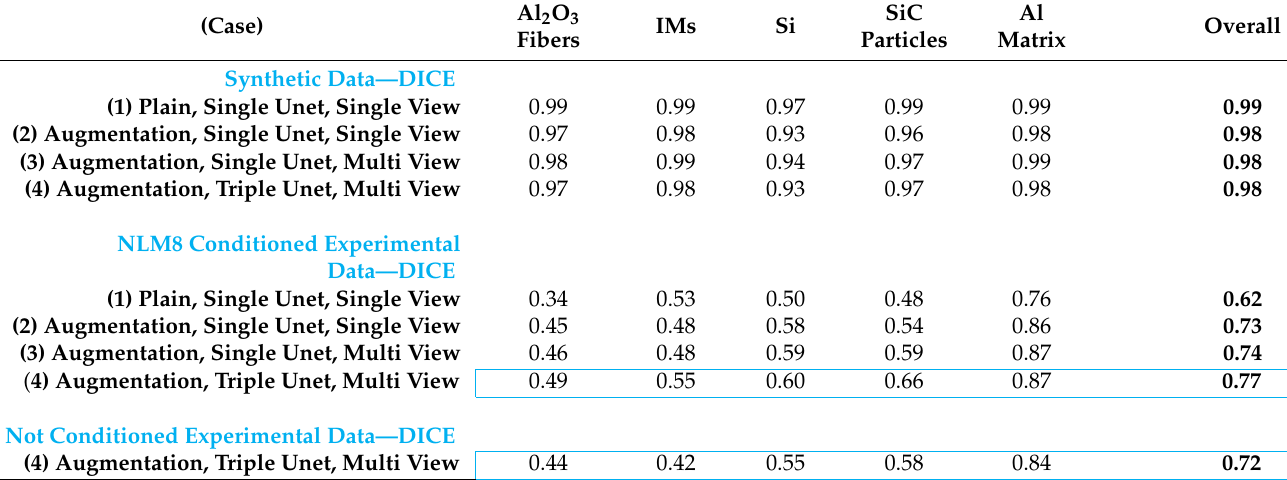
Table 2. Quantitative assessment of the synthetic XCT segmentation, NLM-filtered segmented experimental XCT data, and the un-conditioned segmented experimental XCT data for all cases (voids phase is not included as it was absent in the ground-truth